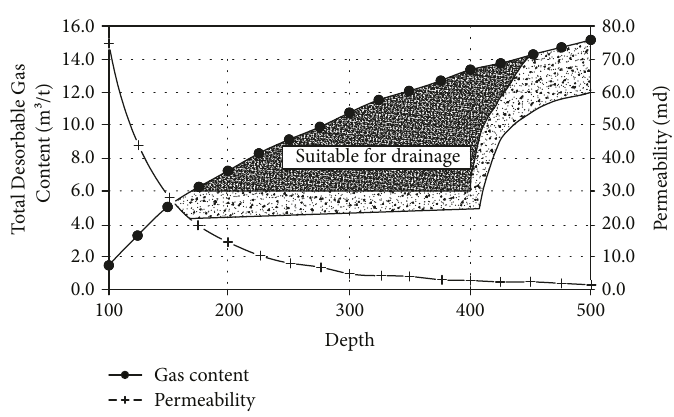
Figure 9: Permeability and gas content relationship with depth (modi fi ed after Ref.